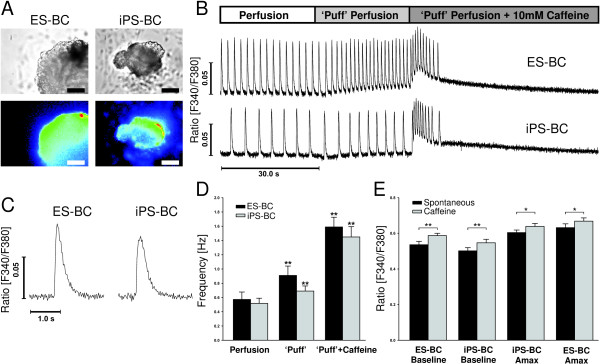
Spontaneous Ca2+ transients of HES-2 and iPS(Foreskin) C1-derived contracting cell clusters. A. Transmission light images of two beating cell aggregates derived from ES and iPS cells that were loaded with Fura-2 AM (upper row) and the corresponding emitted fluorescence light presented in pseudo color. (Scale bar = 100 μm). B. Response of spontaneously beating aggregates derived by both cell lines to caffeine (10 mM) treatment indicates the existence of caffeine-releasable Ca2+ stores in this stage of development (up to 2 weeks after onset of beating). Two representative experiments are shown: 30 s tyrode perfusion followed by 'puff' perfusion of tyrode directly in front of the cells for the same time period with subsequent caffeine application. Both cell types temporally show a caffeine evoked increase of basal, systolic and diastolic [Ca2+]i. However the Ca2+ amplitude is reduced, accompanied by an increase in beating frequency. C. Representative single tracings. The transients show statistically identical characteristics regarding basal Ca2+ level, amplitude, maximum upstroke velocity (Vmax, upstroke) and maximum decay velocity (Vmax, decay) with p > 0.05 (data not shown). D+E Caffeine response (n = 7 for iPS-CMs; n = 7 for ES-CMs). Beating frequency is increased by 'puff'-perfusion and subsequent caffeine application in both celltypes (D). Basal calcium levels and the maximum value (Amax) are raised significantly after caffeine treatment (E). * = p < 0.05; ** = p < 0.01. Additional analyses of these measurements are provided in Additional file 1, Tables S3 and S4.